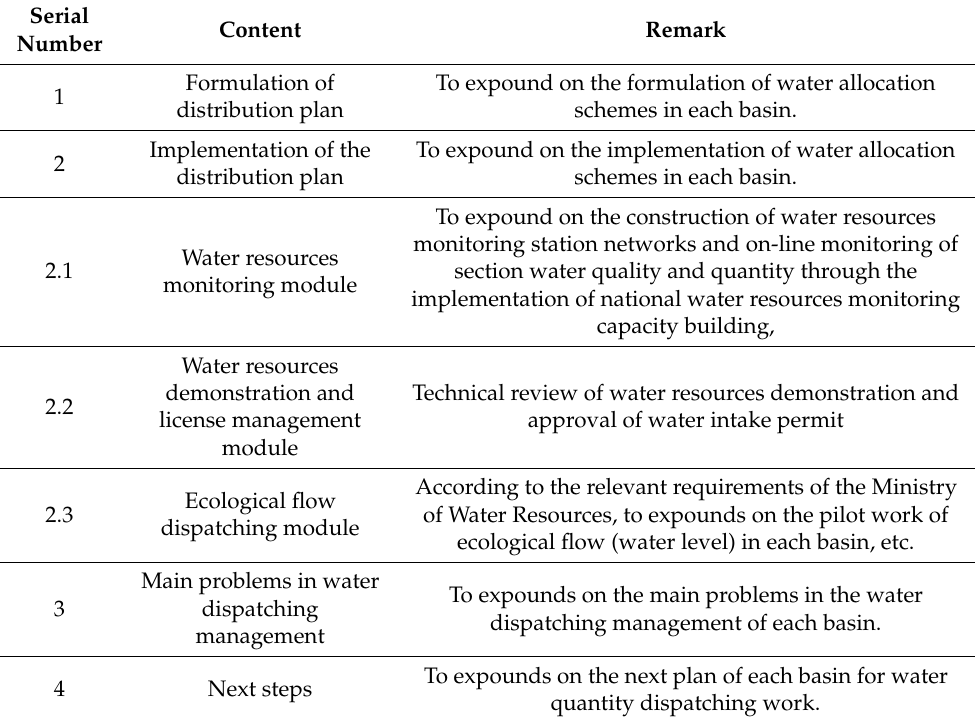
Figure 3. The situation with respect to the application of water resource dispatching. Table 2. Questionnaire for Basin Managers (Sample